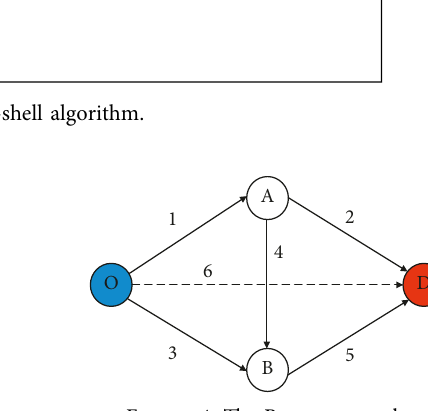
Figure 4: The Braess